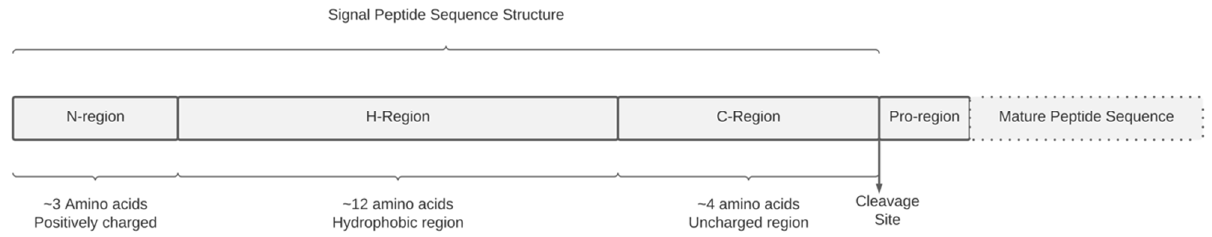
Figure 1. Characteristic SP sequence structure. Classically, the positively charged N-terminal region is composed of 1–5 residues, the hydrophobic core of 7–15 residues, and the uncharged C-region, which contains 3–7 residues. The cleavage site borders the C-region and the pro region.